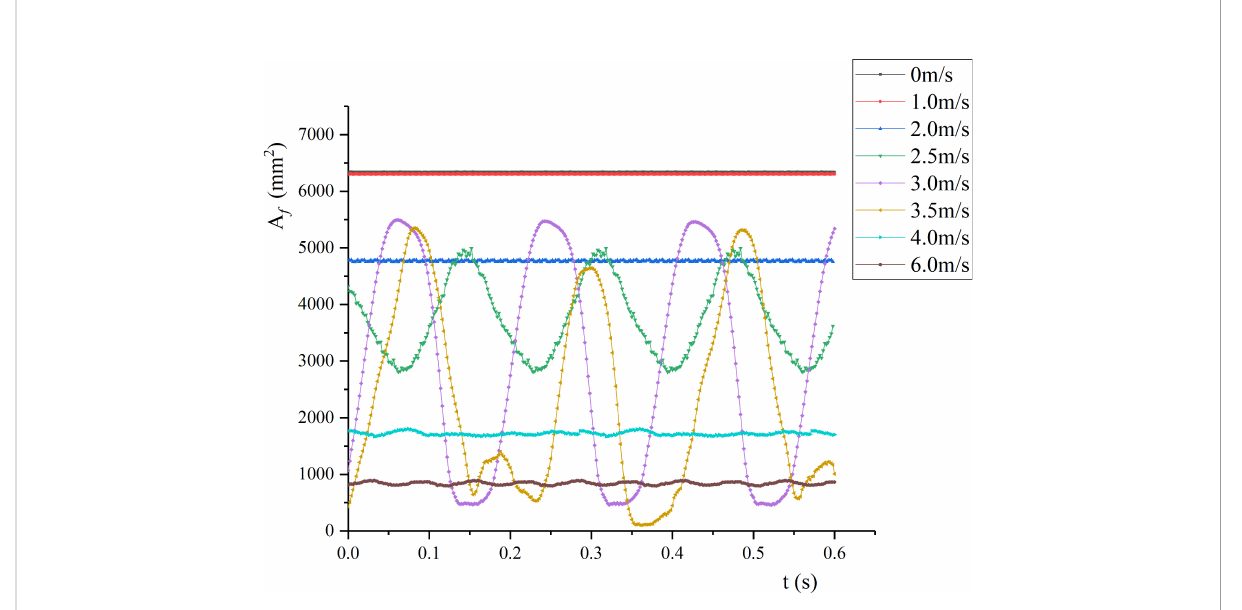
FIGURE 8 Wind de fl ection areas of pear leaf under different air velocities.